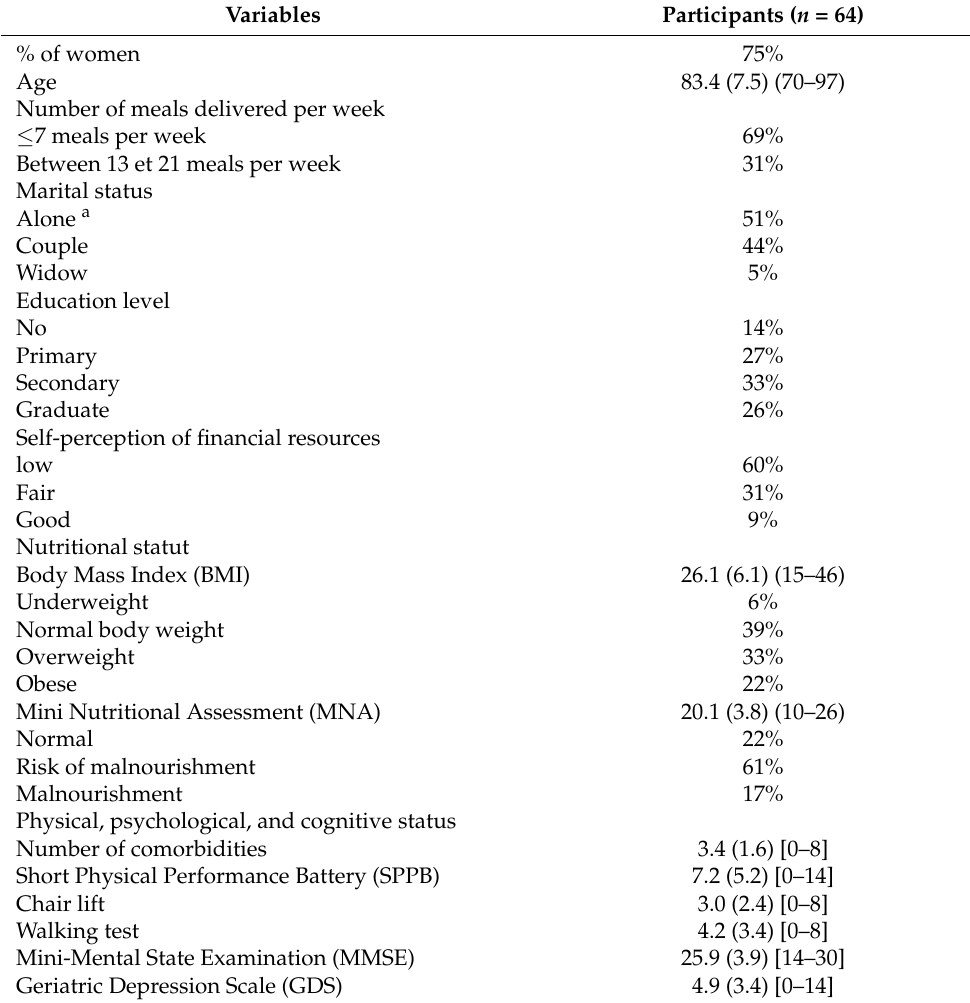
Table 2. Participant characteristics. Means are presented with standard deviations (in parentheses). The values in brackets are the minimum and maximum